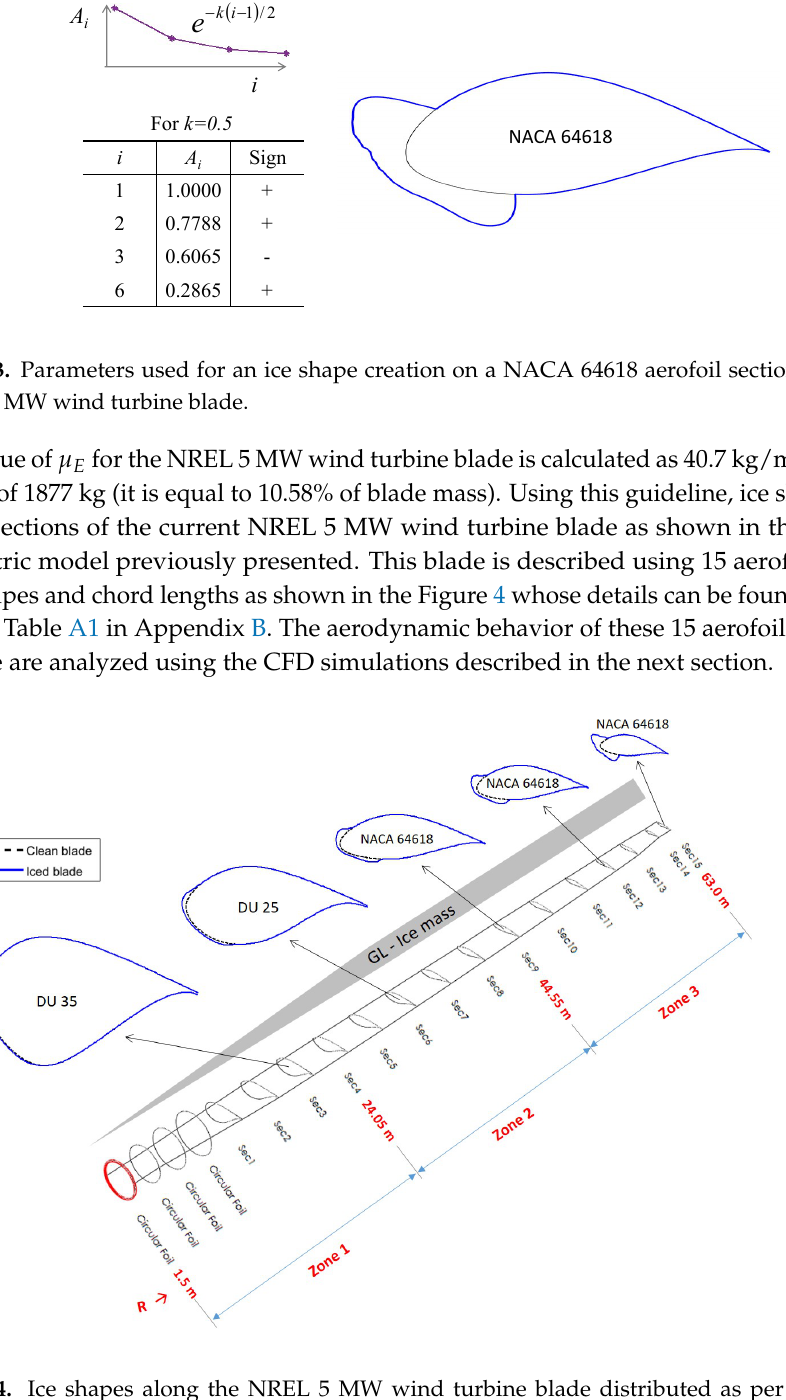
Figure 4. Ice shapes along the NREL 5 MW wind turbine blade distributed as per GL ice mass specification: The blade length is divided into three zones and influence of icing in each of these zones on the turbine power and vibrations is investigated later in Section